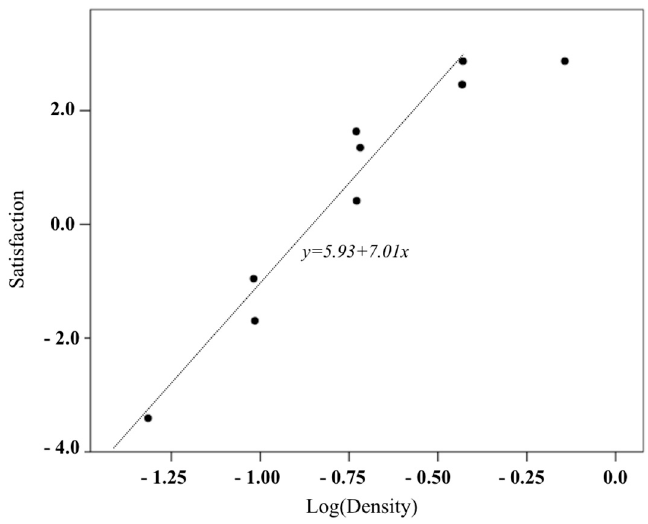
Figure 5. Scatter plot between satisfaction and cookie box